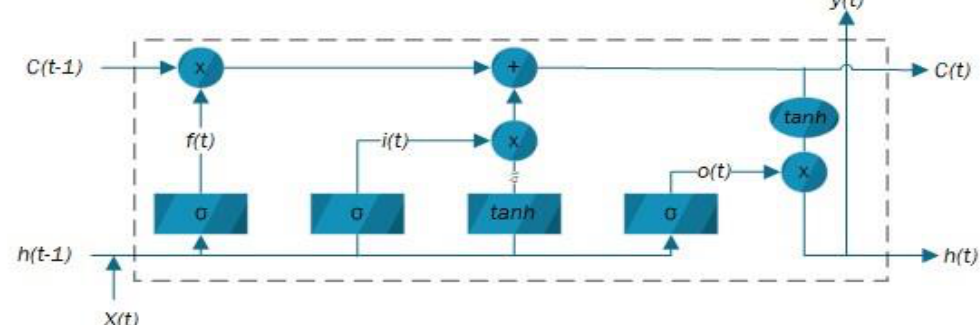
Figure 1. Each unit of LSTM Architecture.